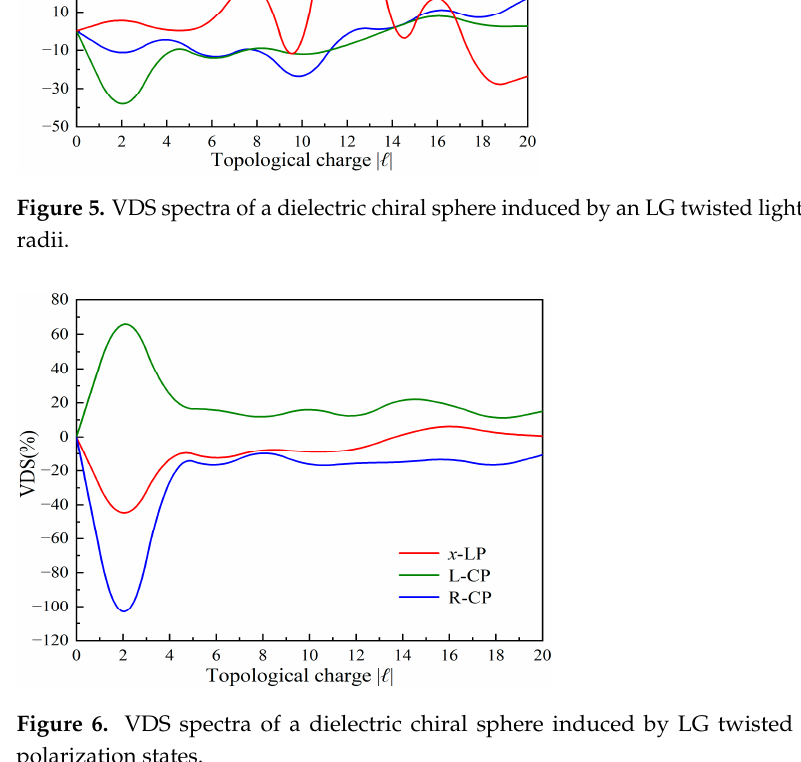
Figure 6. VDS spectra of a dielectric chiral sphere induced by LG twisted light with different po-